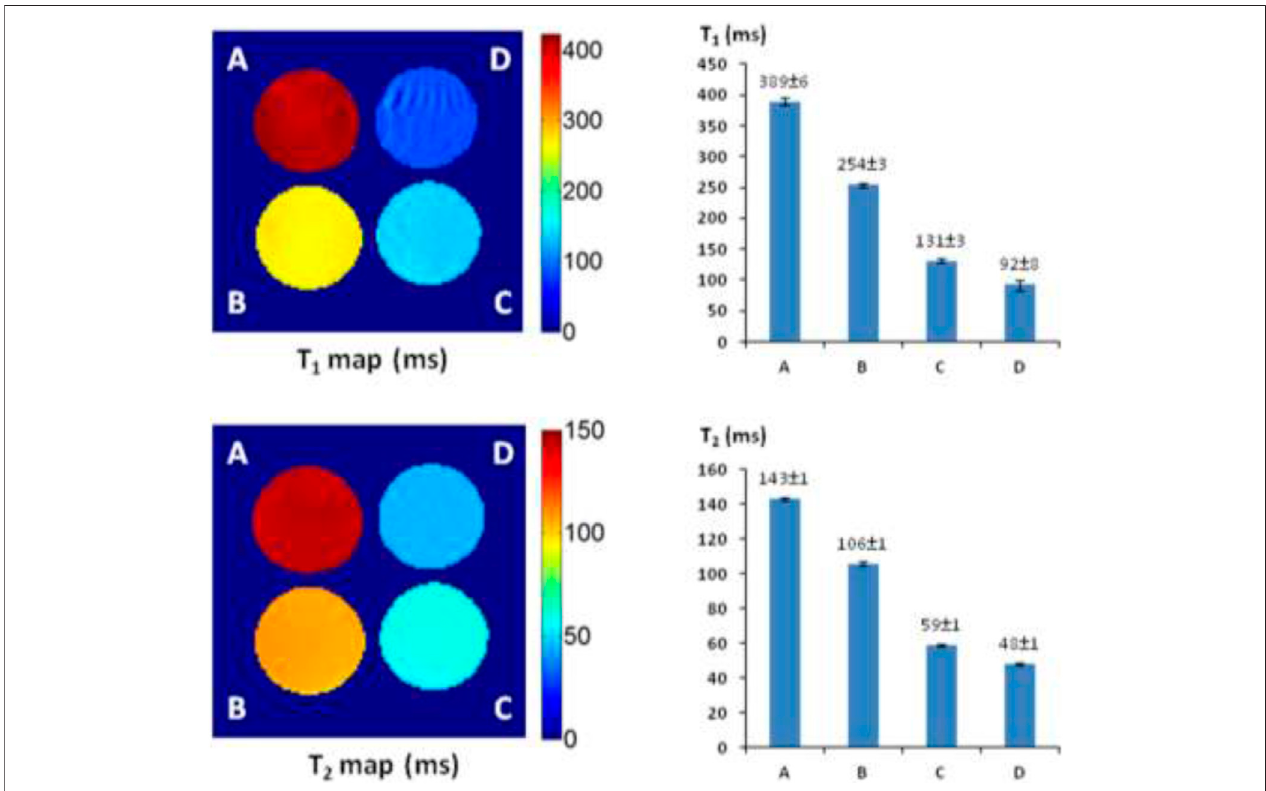
FIGURE 2 | The 1 H-MRI of an Fe 3+ – alizarin complex. MRI acquisition parameters: 1 H-MRI, 200 MHz, matrix size: 128 × 128, FOV: 40 mm × 40 mm, slice thickness: 2 mm; receiver bandwidth: 20 kHz, T 1 -map: saturation recovery spin-echo sequence, TR (cid:1) 200, 400, 600, 800, 1,000, 2000, 3,000, and 6,000 ms, respectively, TE (cid:1) 15 ms; T 2 -map: multi-echo SE sequence, TE (cid:1) 10, 20, 30, 40, 50, 60, 70, 80, 90, 100, 110, 120, 130, 140, 150, and 160 ms, respectively, TR (cid:1) 2000 ms. (A) Control, FAC (15.0 mM); ( B ) alizarin (2.5 mM), FAC (15.0 mM); (C) alizarin (6.0 mM) and FAC (15.0 mM); (D) alizarin (9.0 mM), FAC (15.0 mM) in 1:1 (V/V ′ ), and DMSO/PBS (0.1 M, pH (cid:1) 7.4) at 37 ° C in 4